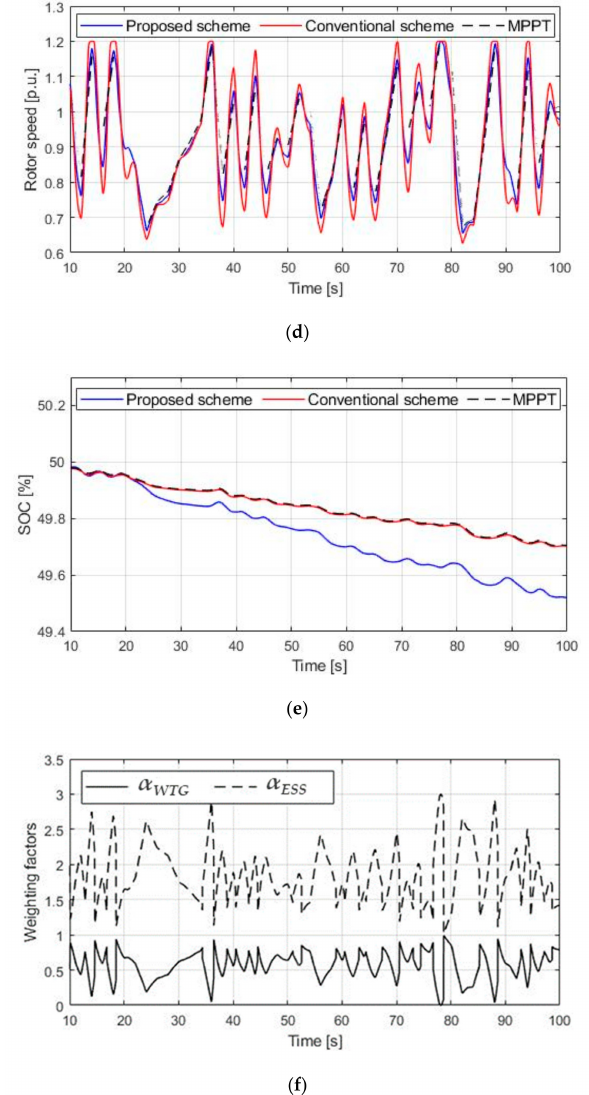
Figure 9. Simulation results for case 1: ( a ) system frequencies, ( b ) active powers of the WTG, ( c ) active powers of the ESS, ( d ) rotor speeds of the WTG, ( e ) SOCs of the ESS, and ( f ) weighting factors of the coordinated